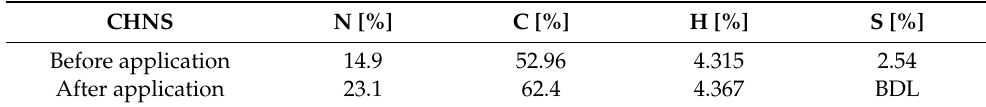
Table 2. CHNS results of Fe-pPD